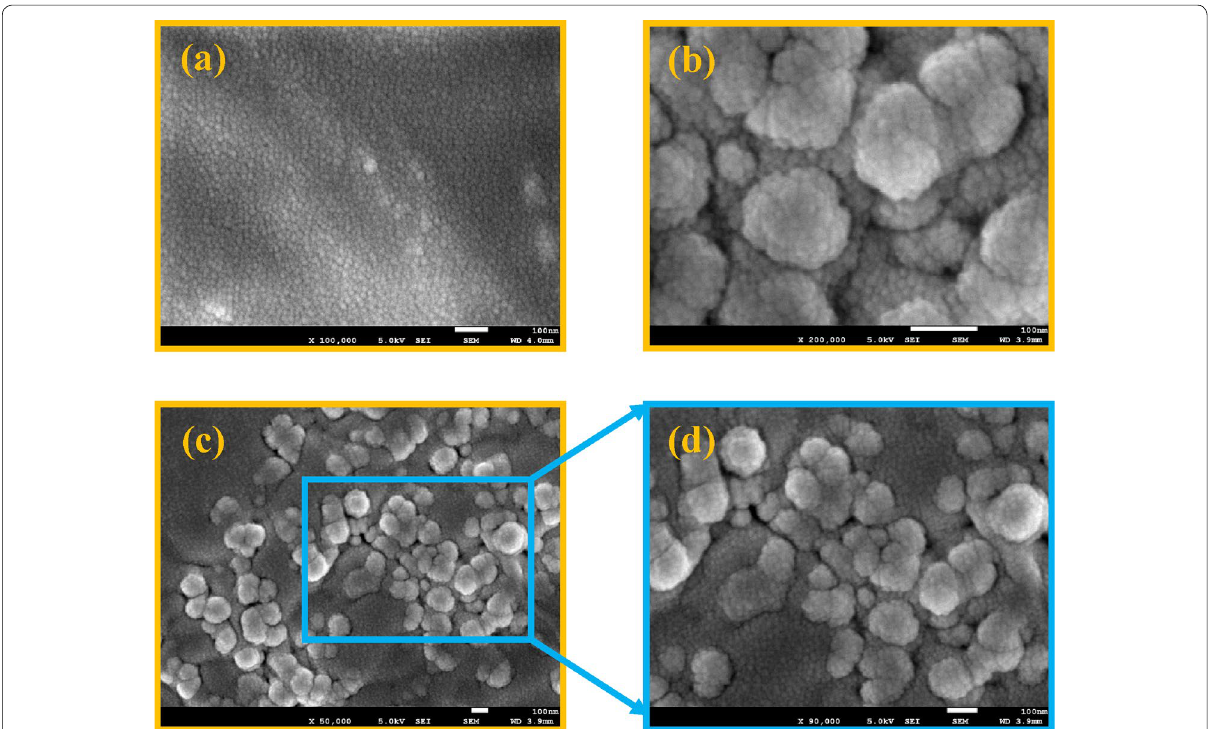
Fig. 5 FE‑SEM images for GNS/EPR 2 a x